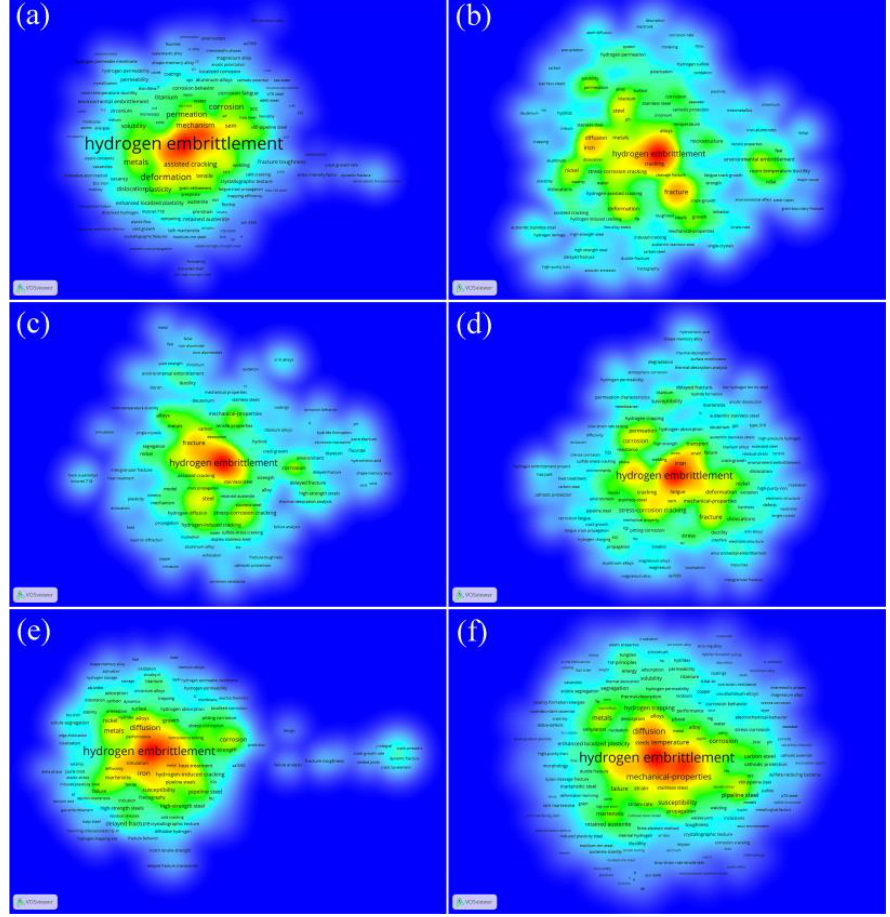
Figure 9. Research hotspots for hydrogen embrittlement research during different periods: ( a ) 1997~2022; ( b ) 1997~2001; ( c ) 2002~2006; ( d ) 2007~2011; ( e ) 2012~2016; ( f ) 2017~2022. density map for keywords from 1997 to 2022, and Figure 9b–f show the maps in different periods. Each keyword in the maps had to occur at least five times in the publications. The node colors depend on the number of occurrences. The frequency increases from blue to 20 keywords in different